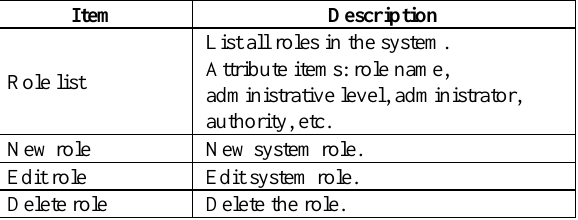
Table 8 . Function items in role management module The organization management module sets up